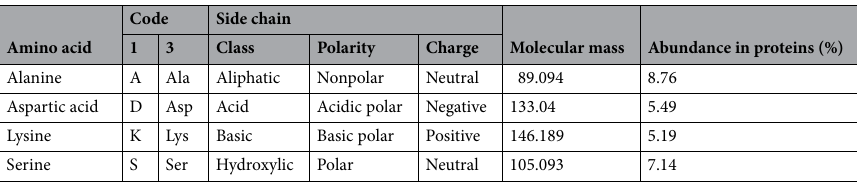
Table 1. A summary of the characteristics of the amino acids explored in this investigation.